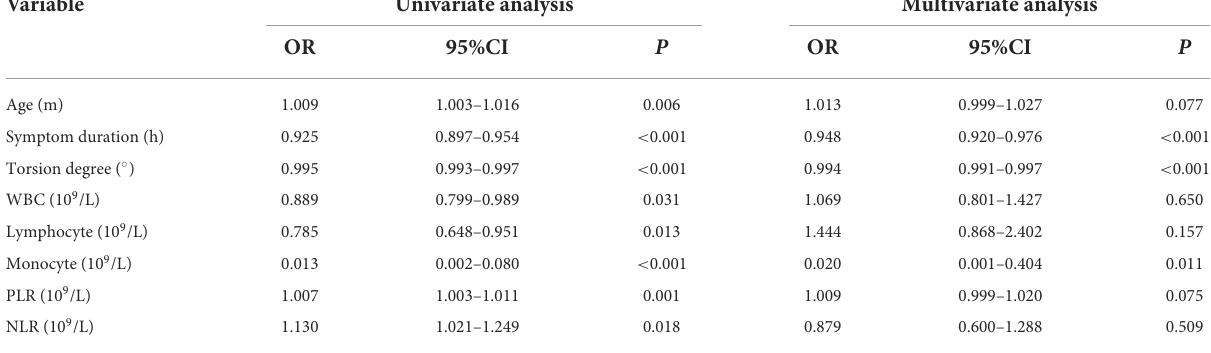
TABLE 3 Univariate and multivariate analyses results.